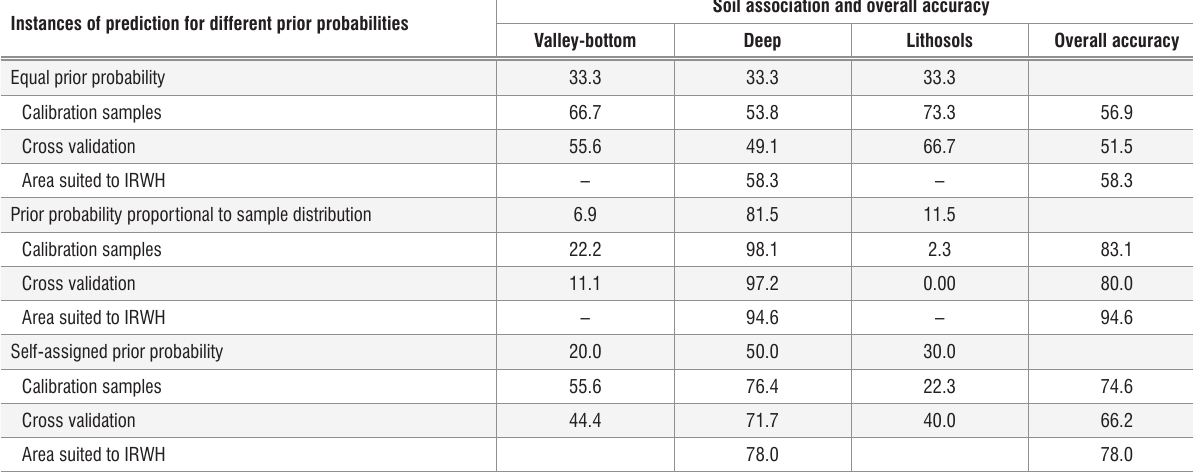
Soil association and overall